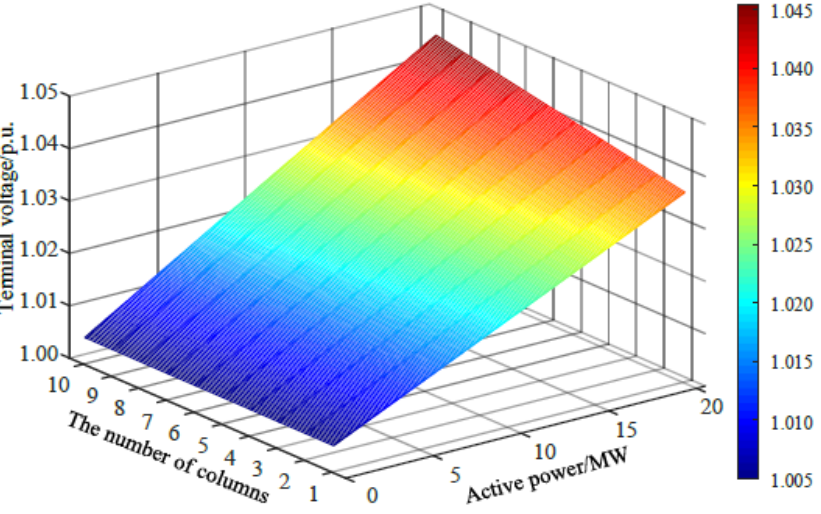
Figure 7. The terminal voltage of the WT.